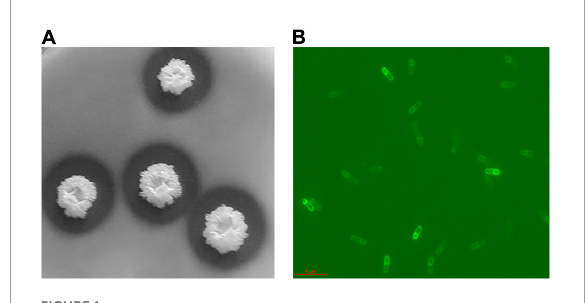
FIGURE1 The morphological characteristics of Bacillus halotolerans DS5. (A) The hydrolyzed transparent circle of Bacillus halotolerans DS5; (B) Fluorescence microscope image of Bacillus halotolerans DS5.